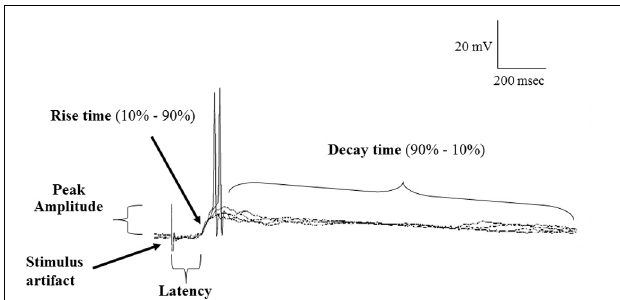
FIGURE 2 | Samples of a continuous recording showing superimposed EPSPs evoked in POA neurons following stimulation of the olfactory bulb under normal (ACSF) conditions and highlighting the properties of EPSPs measured. Note that evoked EPSPs could give rise to action potential firing and showed constant latency and rise time, consistent with a monosynaptic